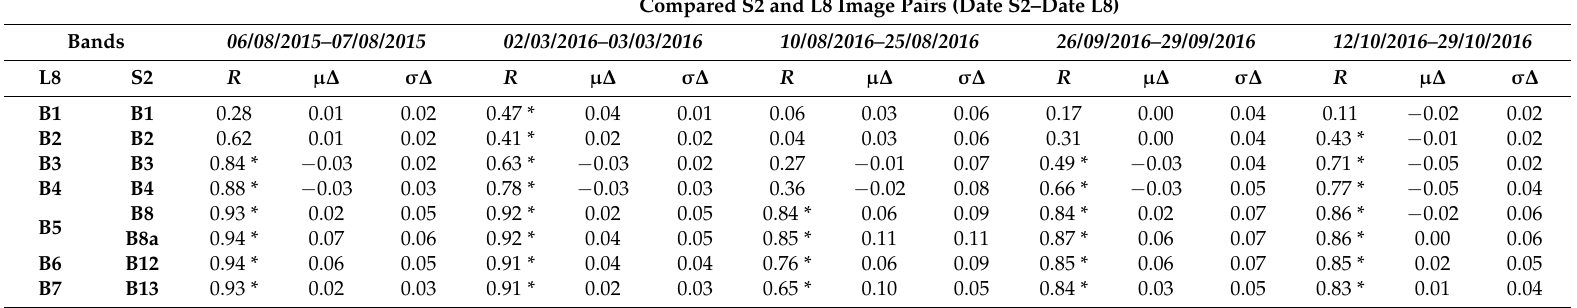
Table 6. Statistics concerning band per band reflectance differences (S2 minus L8). Selected combinations are those relating bands that reasonably can be supposed a-priori correlated (i.e., bands belonging to the same region of the spectrum). When compared S2 and L8 scenes are the closest ones within the time series. Reported values show that reflectance differences are acceptable. R is the Pearson’s correlation coefficient. * Correlations are significant at p =